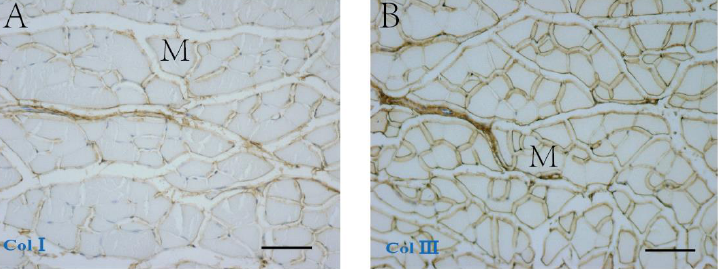
Figure 5. Immunohistochemical staining of collagen type I ( A ) and collagen type III ( B ) in the perimysium and endomysium of 8 month old mouse muscle (Group B). M = muscle cell. Scale bar: 50 μm. Table 4. The percentage area of collagen and the AOD (average optical density) of COLI and COLIII in the skeletal muscle of the mice.